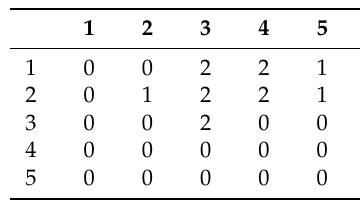
Table 1. Reduce Table 1. Reduce matrix.